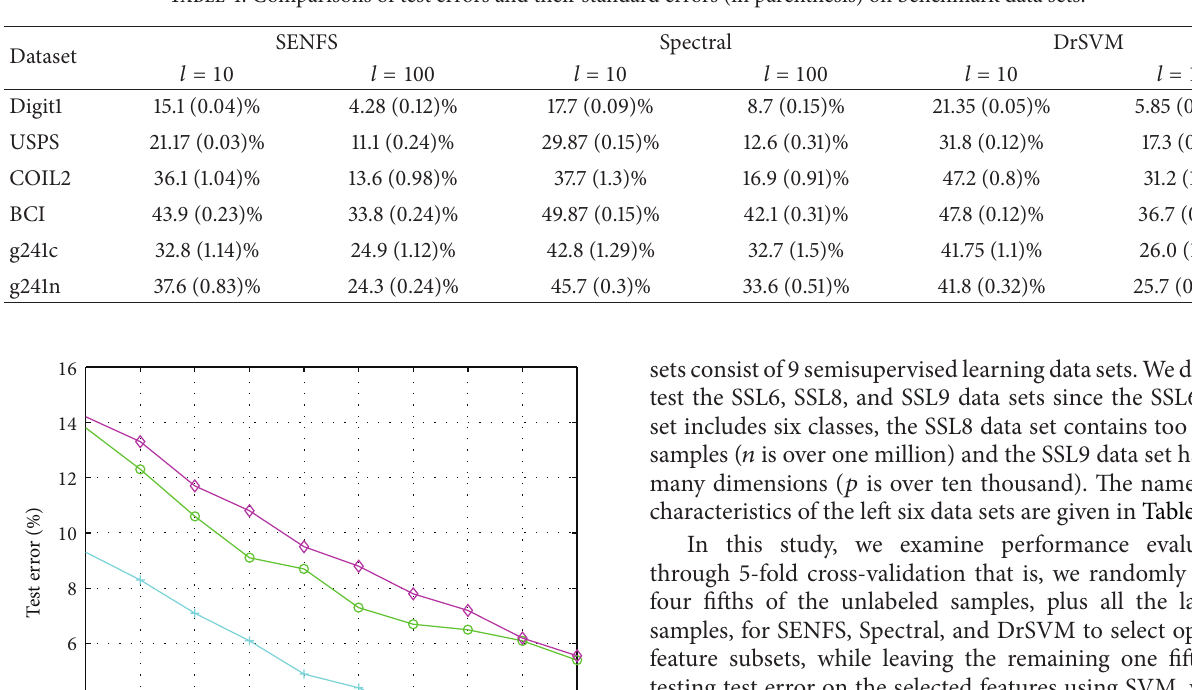
Table 4: Comparisons of test errors and their standard errors (in parenthesis) on benchmark data sets.